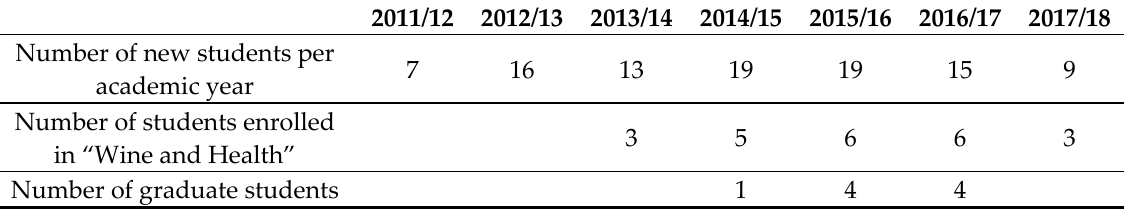
Table 1. Students enrolled in the Degree in Oenology and in the optional subject “Wine and